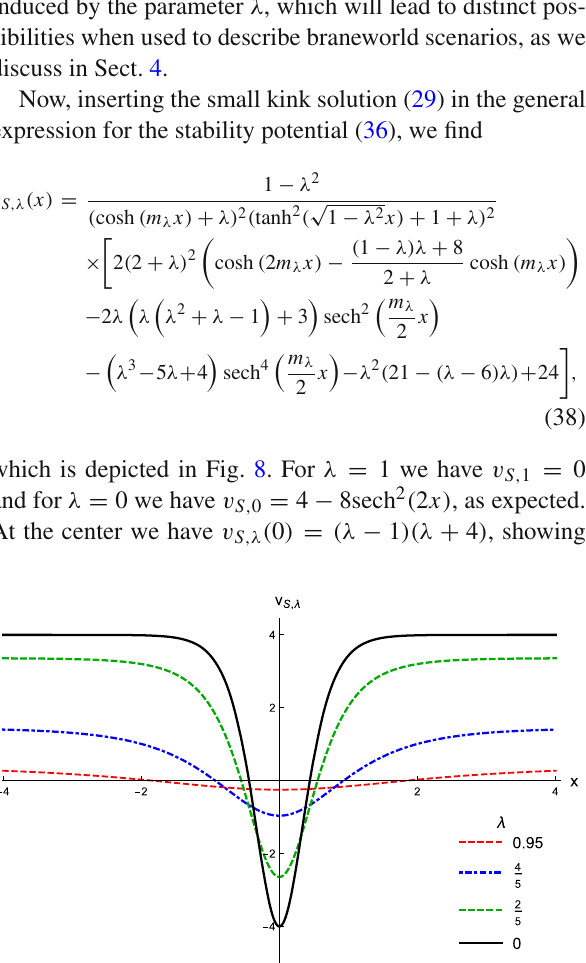
Fig. 8 The stability potential v S ,λ ( x ) (38) for some values of λ . Here we observe that, as λ increases, its depth diminishes and disappears at λ = 1